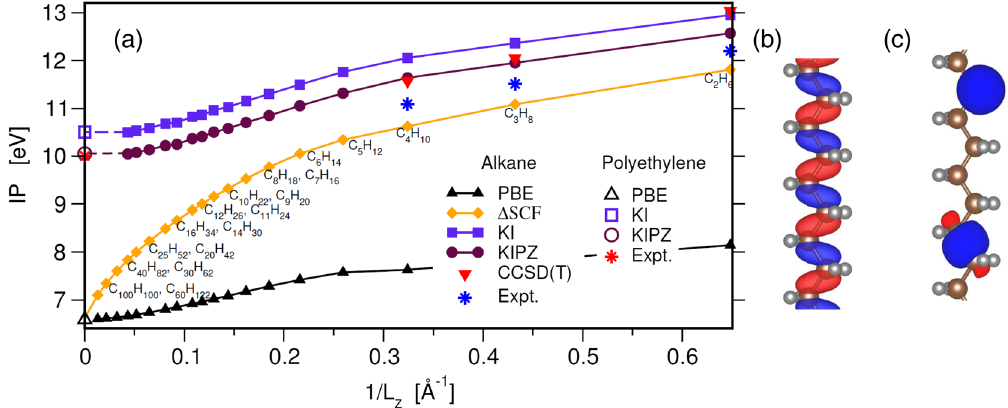
FIG. 1. (a): IP energy as negative of the HOMO energy for linear alkane molecules as a function of the inverse of the system length ( L in Å) and polyethylene (infinite chain), computed with DFT-PBE, Δ SCF, KI, and KIPZ. Δ SCF and CCSD(T) results refer to IPs z calculated as total energy differences evaluated at the PBE and CCSD(T) level, respectively; the Δ SCF results for L extrapolation. The right panels show (b) the VBM (canonical) orbital of polyethylene computed with DFT-PBE and (c) two types of variational orbitals for the same system computed using KIPZ. For these model systems, geometries were not